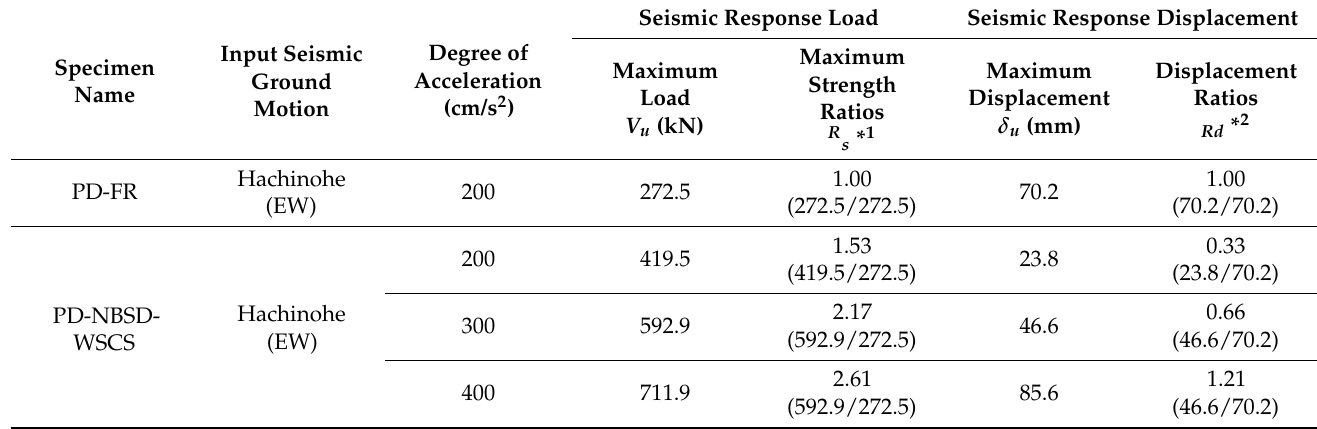
Table 10. Comparison of seismic response strength ratios and displacement